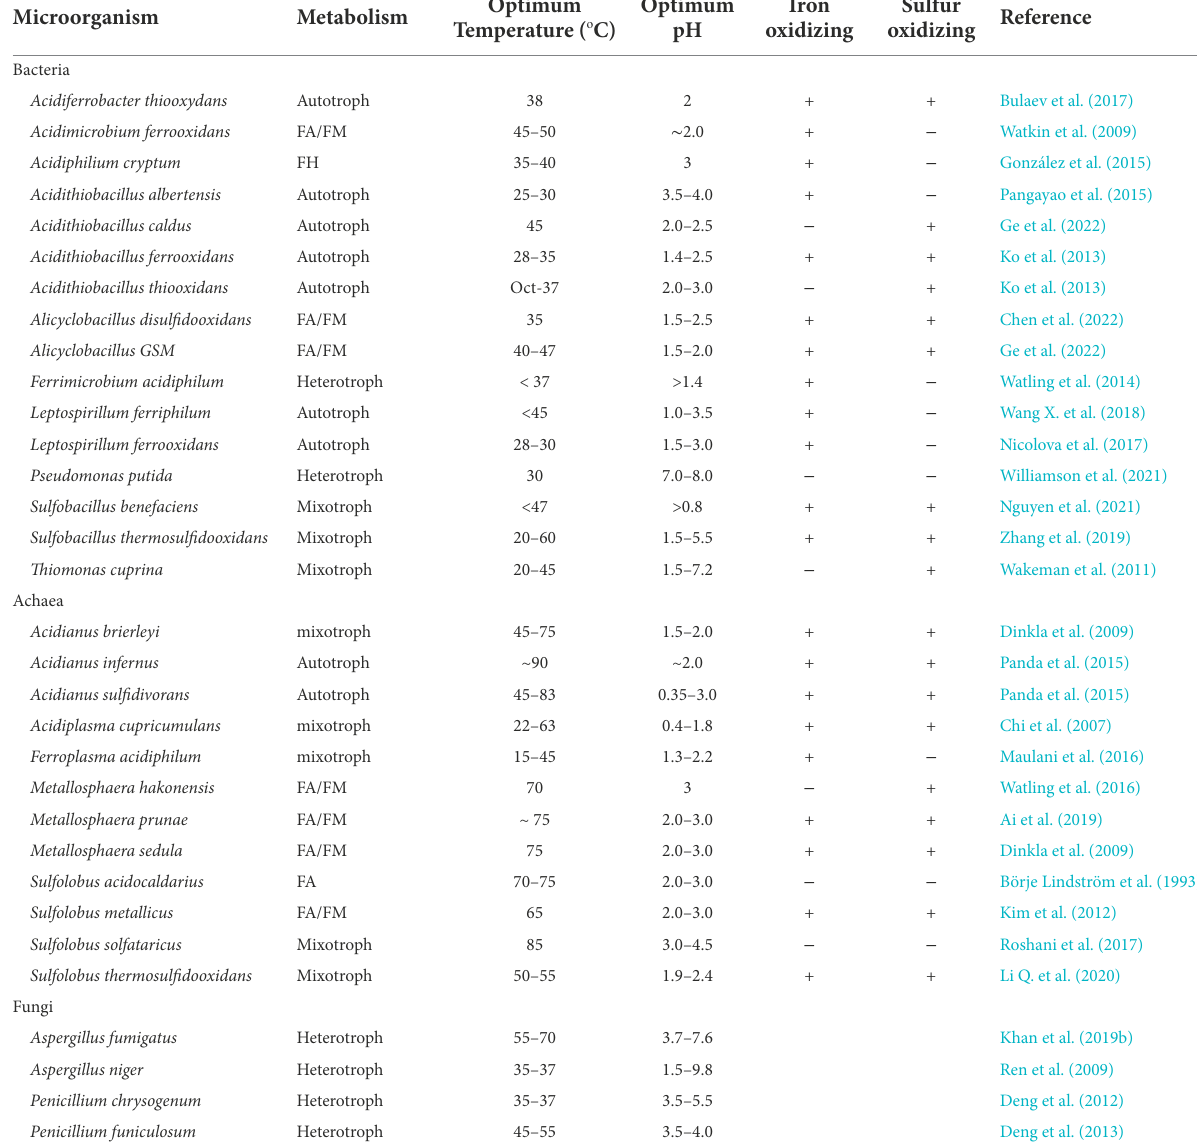
TABLE 1 A summary of microorganism mostly used in bioleaching.